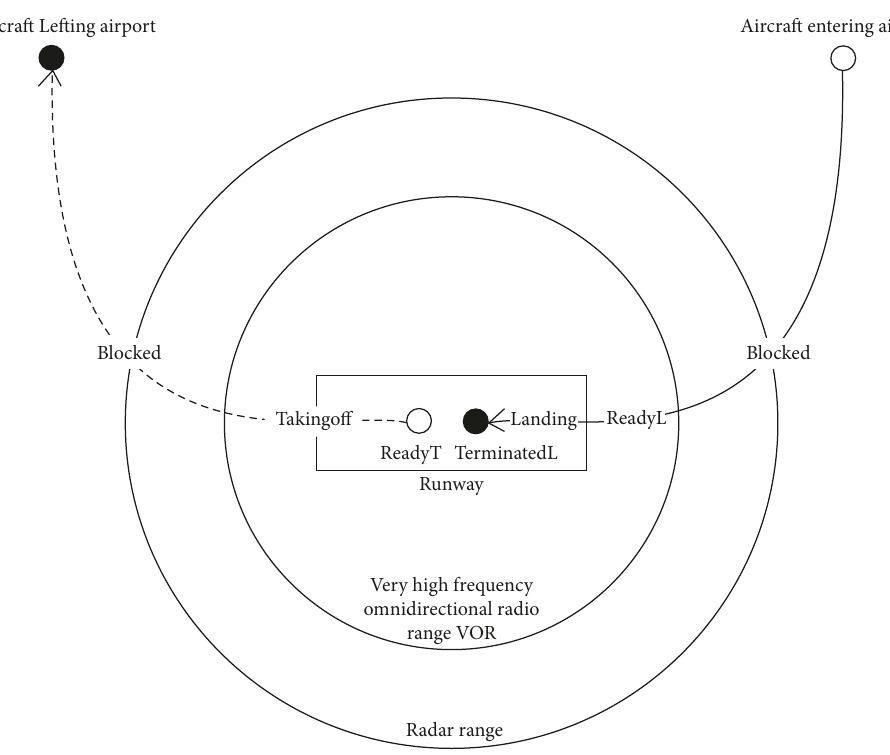
Figure 3: Aircrafts landing/taking off